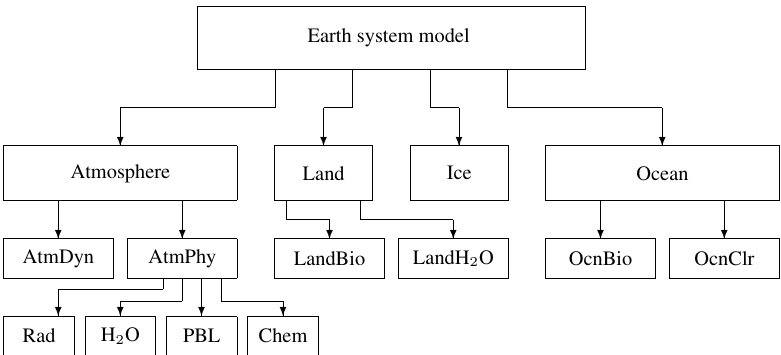
Figure 2. Notional architecture of an Earth system model, with components embodying different aspects of the climate system, hierarchically organized. Models on a hierarchy of complexity ranging from single-component (e.g., atmosphere-only) models to full-scale coupled models with an interactive biosphere, are often constructed out of a palette of components within a single modeling system. How the notional architecture of Figure 2 gets translated into a parallel coupled ESM code is quite problem-specific. As the 10 science evolves and computing power grows, the boundary of what is resolved and unresolved changes. Also, models grow in sophistication in terms of the number of processes and feedbacks that are included. For the purposes of this study, we describe the actual code architecture of the GFDL Flexible Modeling System (FMS). The atmosphere and ocean components are set up to run in parallel in distributed memory, communicating on the slow coupling timestep ∆ t cpld , on the order of ∆ t cpld = 3600 sec for its flagship application, decadal-centennial climate change. Within the 15 slow coupling loop, the atmosphere communicates on a fast coupling timestep ∆ t atm with a typical value of 1200 sec, set by the constraints of atmospheric numerical and physical stability.